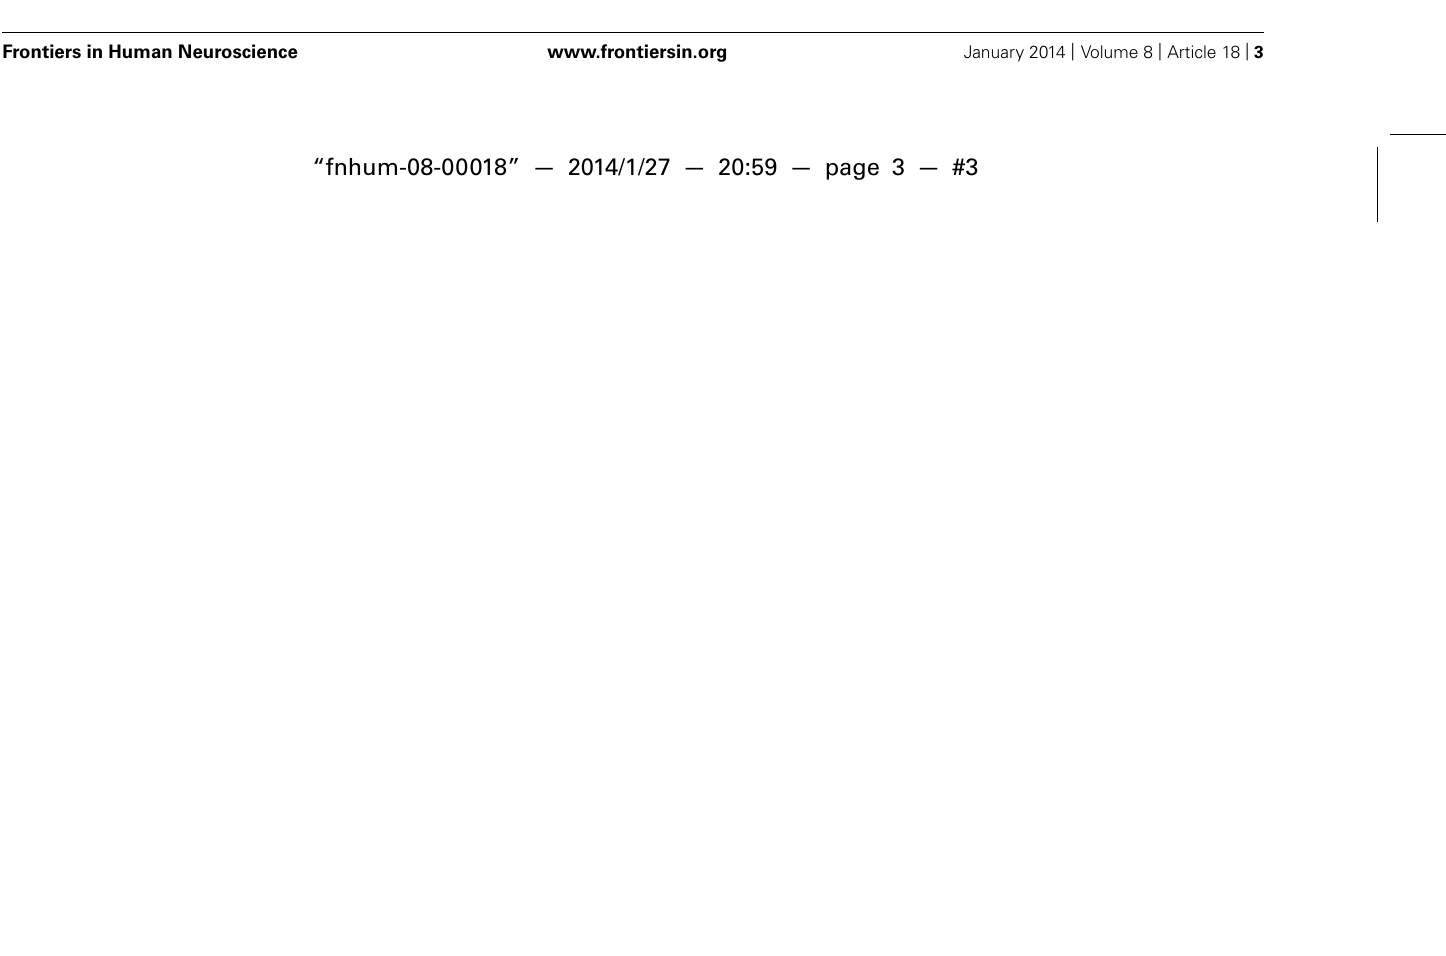
represent a scene-first trial, and test (B). Note that, during test, scenes were always presented first, generating a scene preview period